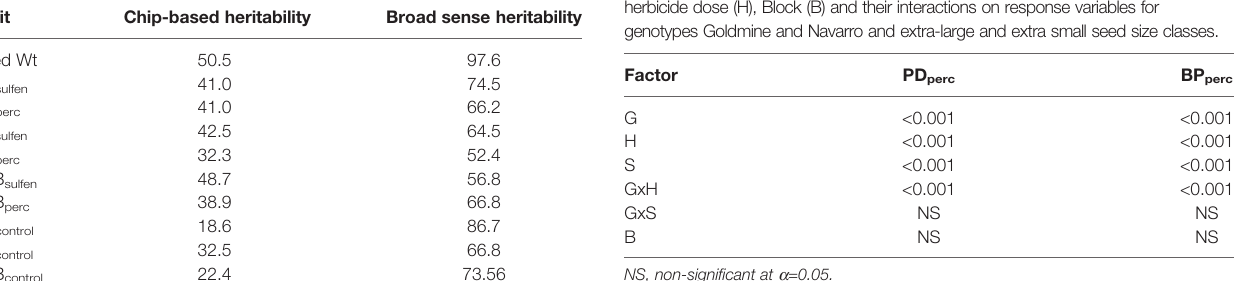
TABLE 4 | Estimated heritability as percentage of total variability observed. Trait